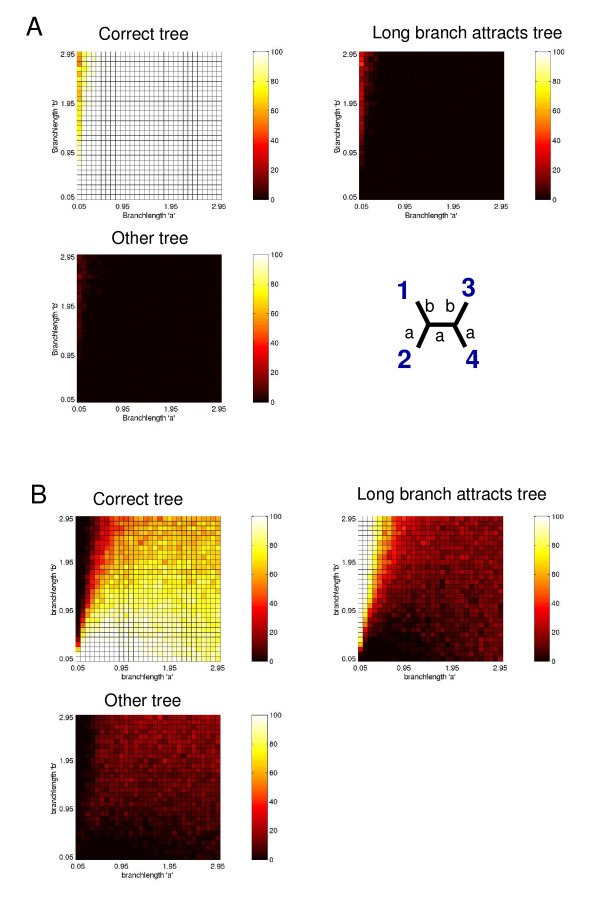
Performance of ML tree reconstructions evaluated using simulations. The performance of ML tree reconstruction with the JTT + F + Γ model for data simulated under (A) the JTT + F + Γ model and (B) under a site-specific frequency model (JTT + ssF + Γ). The site-specific frequency data were derived from the HSP90 data set. The three heatmaps in (A) and (B) represent, respectively, the proportions of "Correct tree" (i.e., taxa 1 and 2 together), "Long branch attracts tree" (i.e., taxa 1 and 3 together) and "Other tree" (i.e., incorrectly put taxa 1 and 4 together) with regard to branch-lengths a and b. The four-taxon tree shown in (A) is the true tree (taxa 1 and 2 together, and taxa 3 and 4 together) used for simulating the data. Each box of the heatmaps represents 100 simulations for the given conditions.